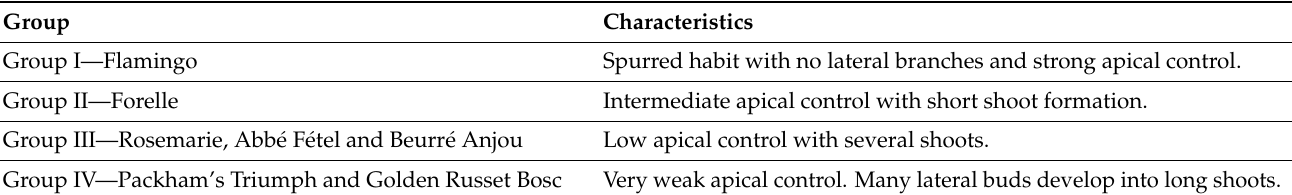
Table 5. Group of pear cultivars classified by habit (Modified from [65]). Group Characteristics Spurred habit with no lateral branches and strong apical control. Intermediate apical control with short shoot